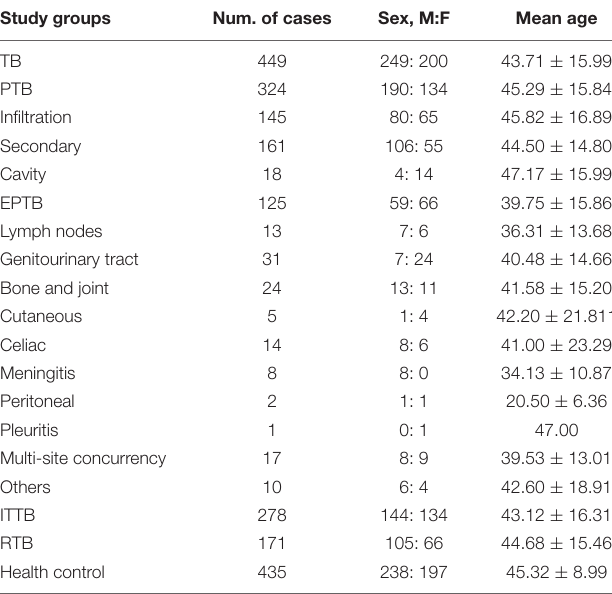
TABLE 1 | Demographics and clinical data for tuberculosis patients and